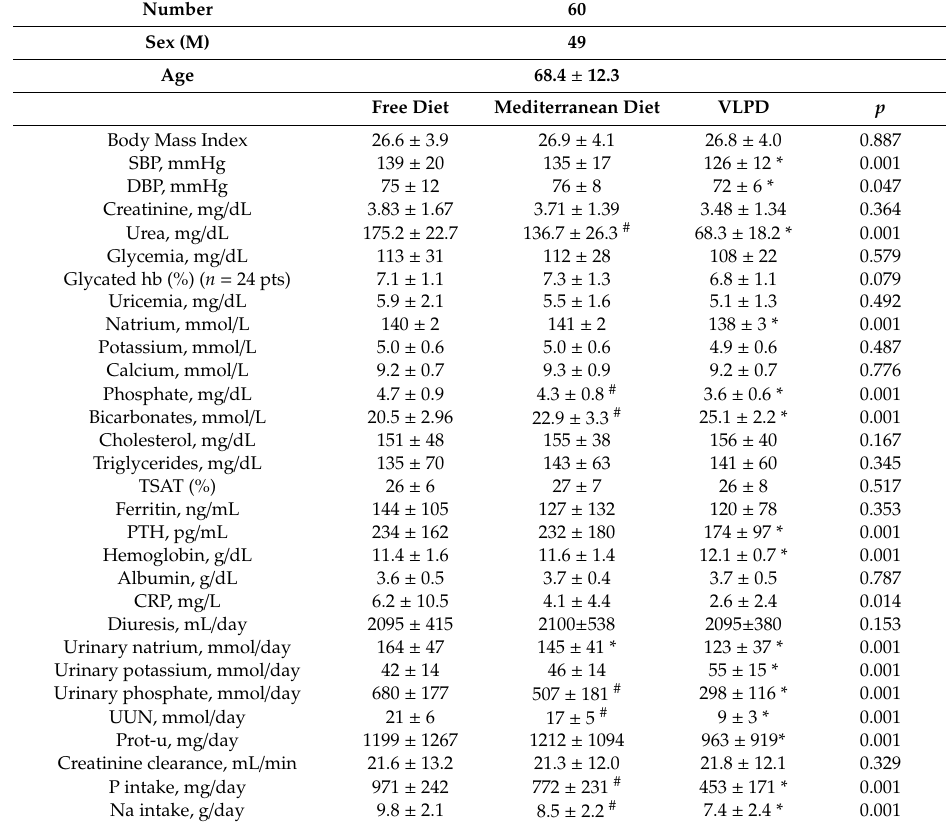
Table 2. Anthropometric, clinical, and biochemical data of patients according to each dietary